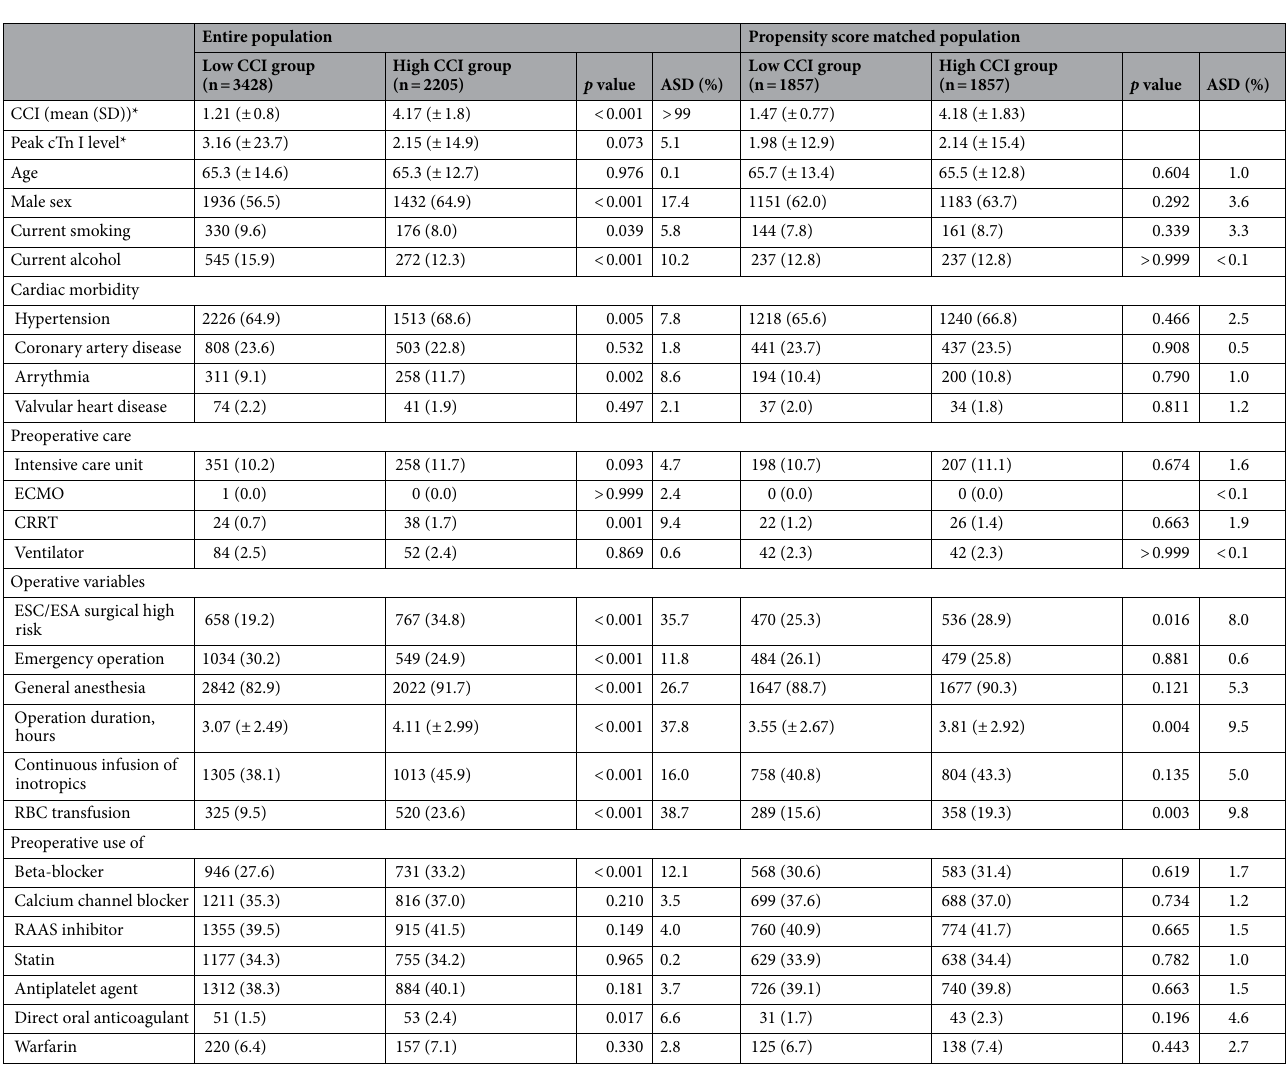
Table 1. Baseline characteristics of entire and propensity score matched population. Data are presented as n (%) or mean (± standard deviation). CCI Charlson Comorbidity Index, ASD Absolute standardized mean difference, ECMO Extracorporeal membranous oxygenation, CRRT Continuous renal replacement therapy, ESC European Society of cardiology, ESA European Society of Anaesthesiology, RBC Red blood cell, RAAS Renin–angiotensin–aldosterone system. *These two variables were not retained in the propensity score